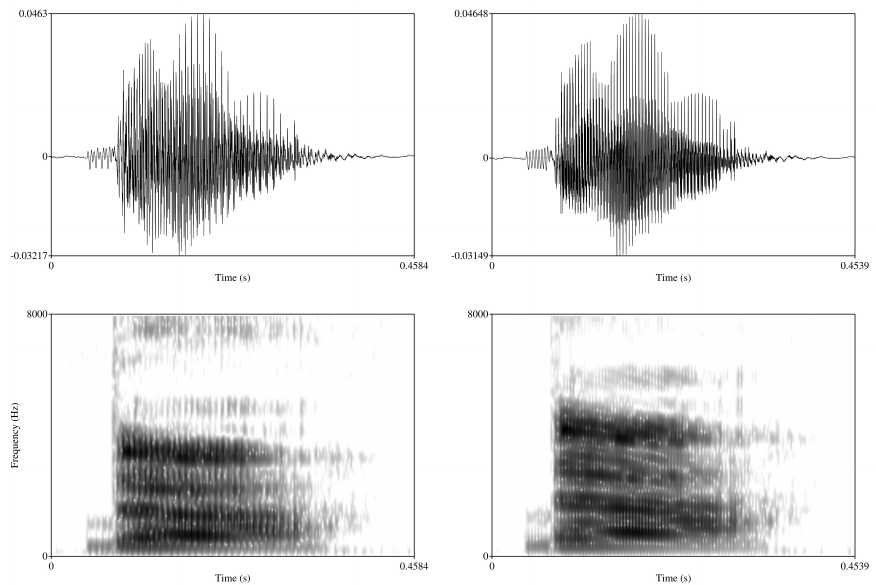
Figure 1. Prevoiced [da] token with − 30 ms VOT. Original male voice ( left ) and resynthesized female voice ( right